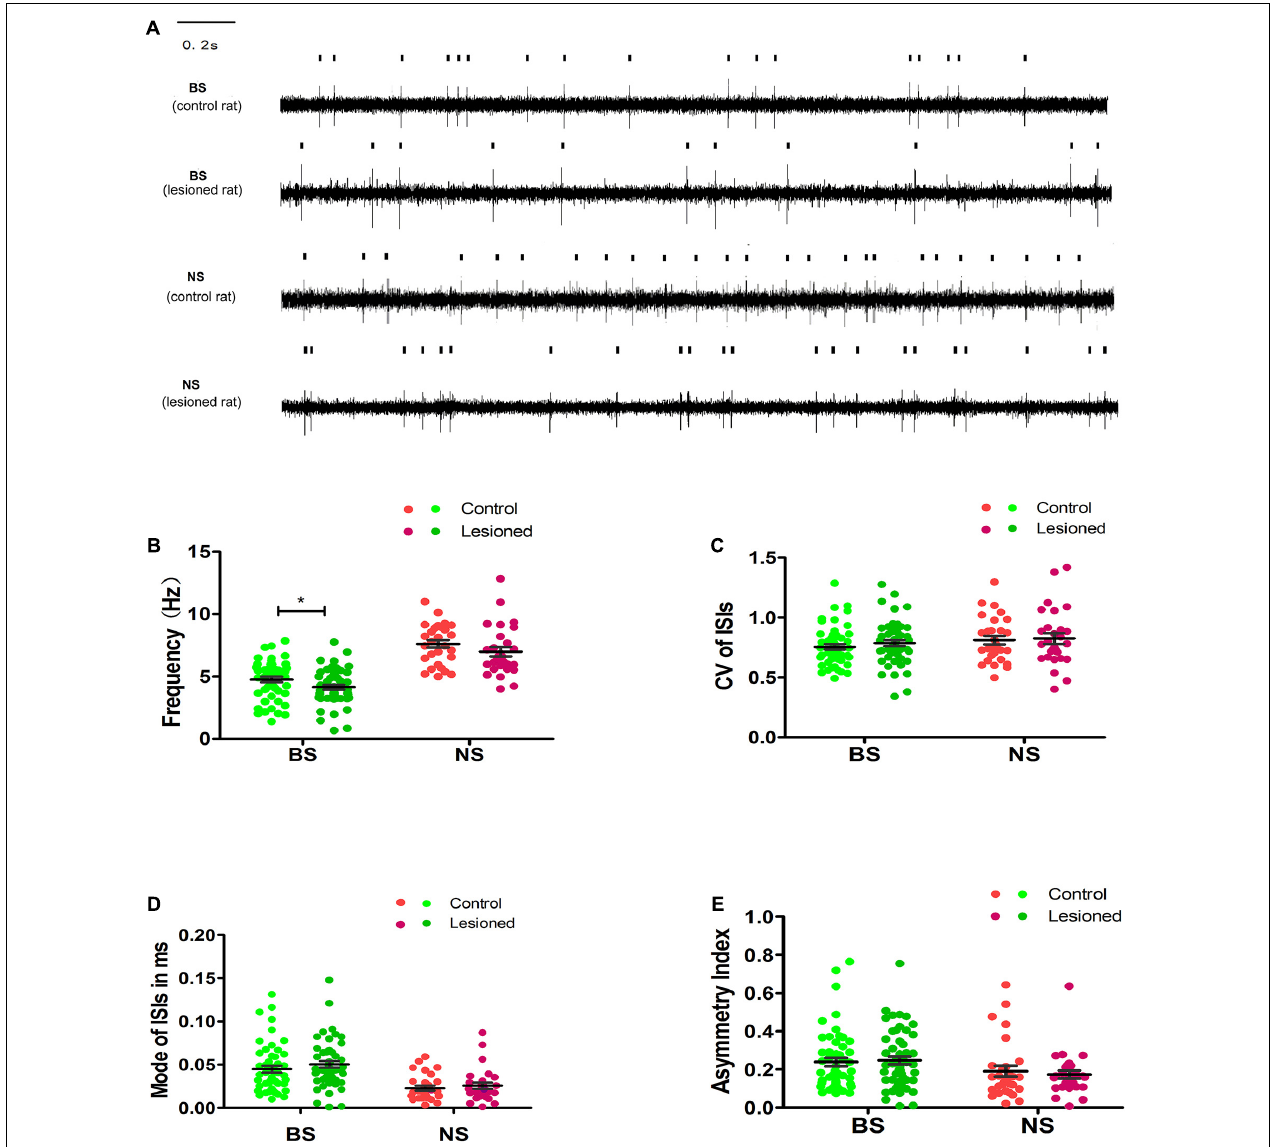
FIGURE 5 | Illustrations of the Unit activity comparison of various parameters between distinct neuron-BS (putative pyramidal neurons) and NS (putative interneurons) from layer 5 of M1 in control and 6-OHDA-treated rats at rest. Representative raw recording of ongoing spikes of identified BS and NS neurons in control and 6-OHDA-treated rats (A) . The dots in the scatter plot showed the mean firing rate for each neuron from BS (green), with light green dots for control rats and dark green dots for 6-OHDA-treated rats, and from NS (red) neurons, with light red dots for control rats and dark red dots for 6-OHDA-treated rats. The comparison between control and 6-OHDA-treated rats was shown in average firing rates (B) , CV value (C) , Mode value (D) , and asymmetry index (E) . Black lines represent mean SEM over all neurons. * Indicates p <